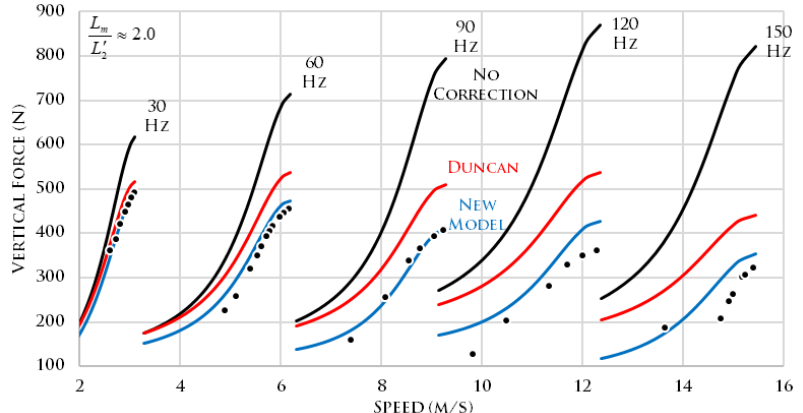
Figure 15. Comparison of vertical force through frequency variation (UD). Average gaps in ascending order [mm]: